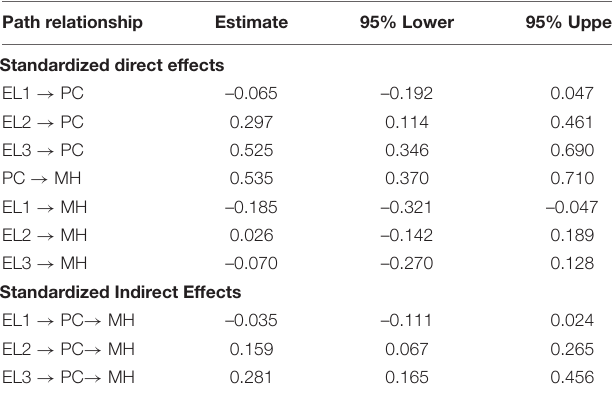
TABLE 2 | Direct and indirect effects and 95% confidence